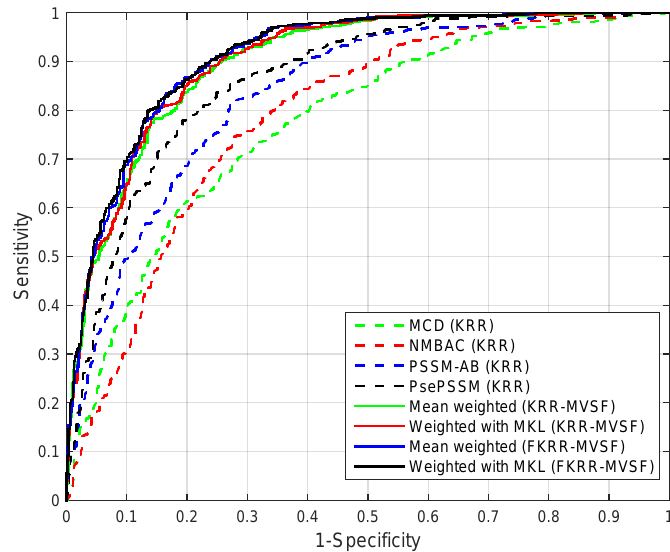
Figure 1. The ROC curve of different kernels (features) on the PDB1075 dataset (Jackknife